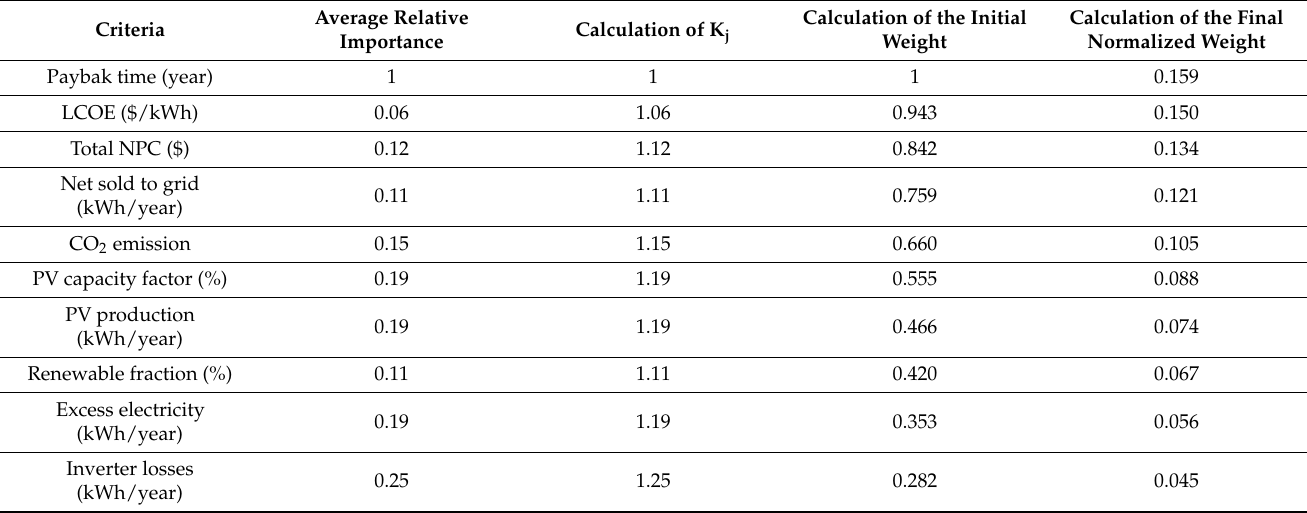
Table 8. Calculating the weight of indices of technical and financial characteristics.